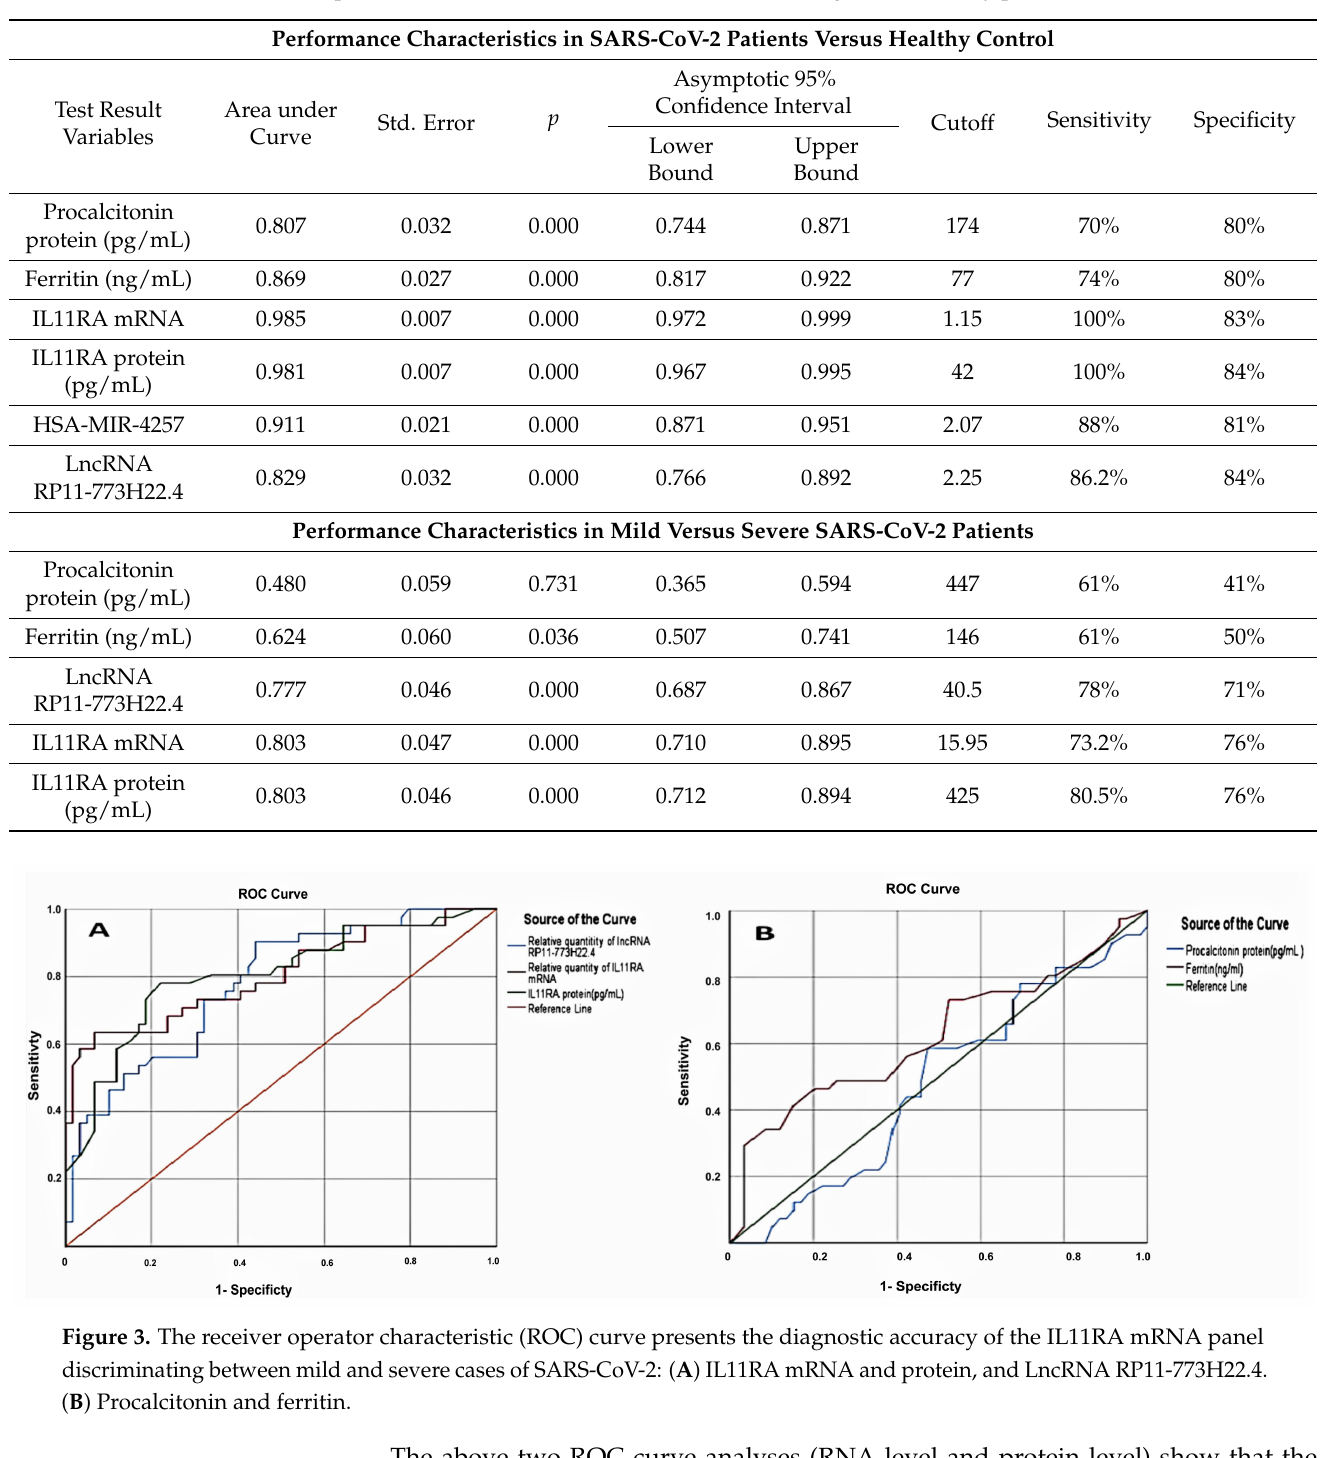
Table 3. The performance characteristics of the different investigated laboratory parameters.